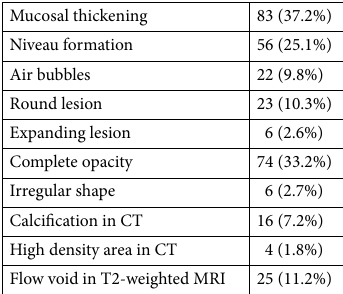
Table 2. Imaging findings of ISSOs patients.